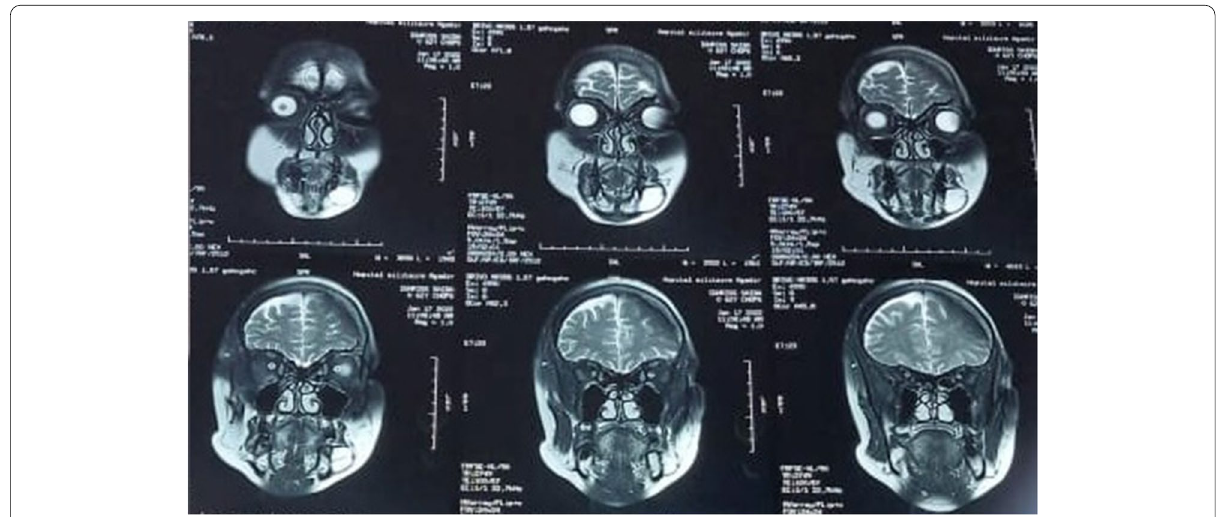
Fig. 1 MRI sections showing T2 hyper-intense lesions, in the left vestibular region